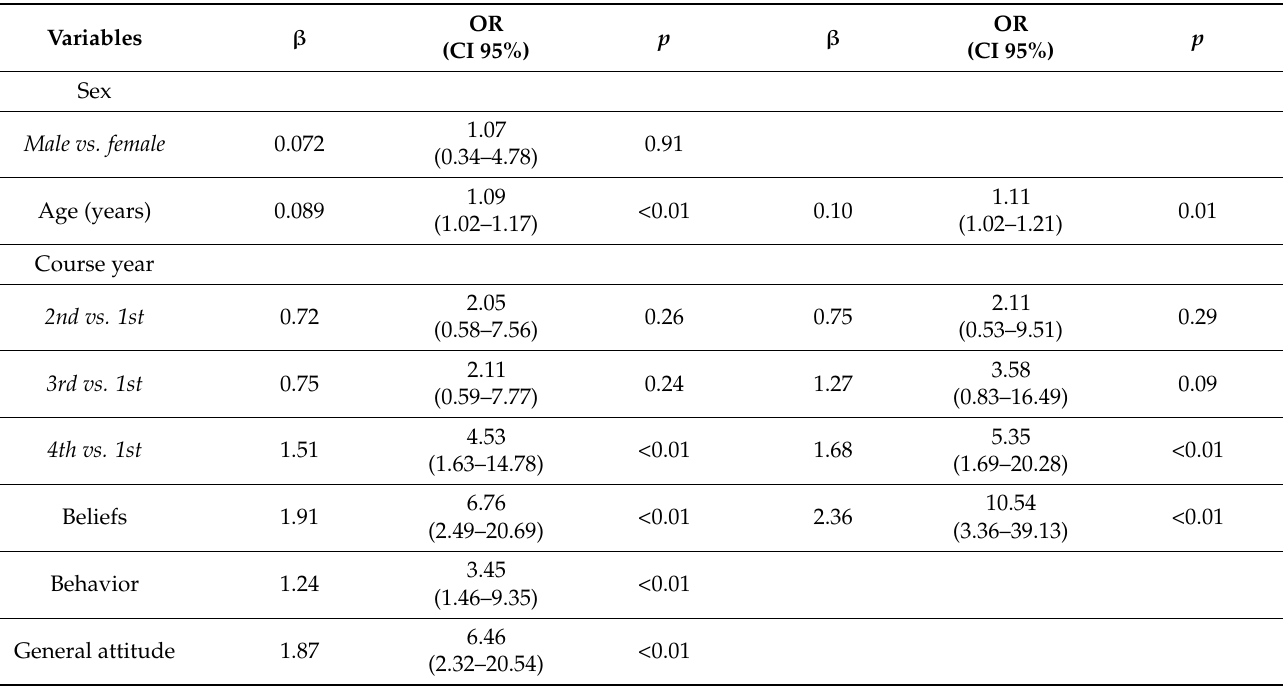
Table 3. Univariable and multivariable binary logistic (best model) regression results considering influenza vaccination status as the dependent variable.